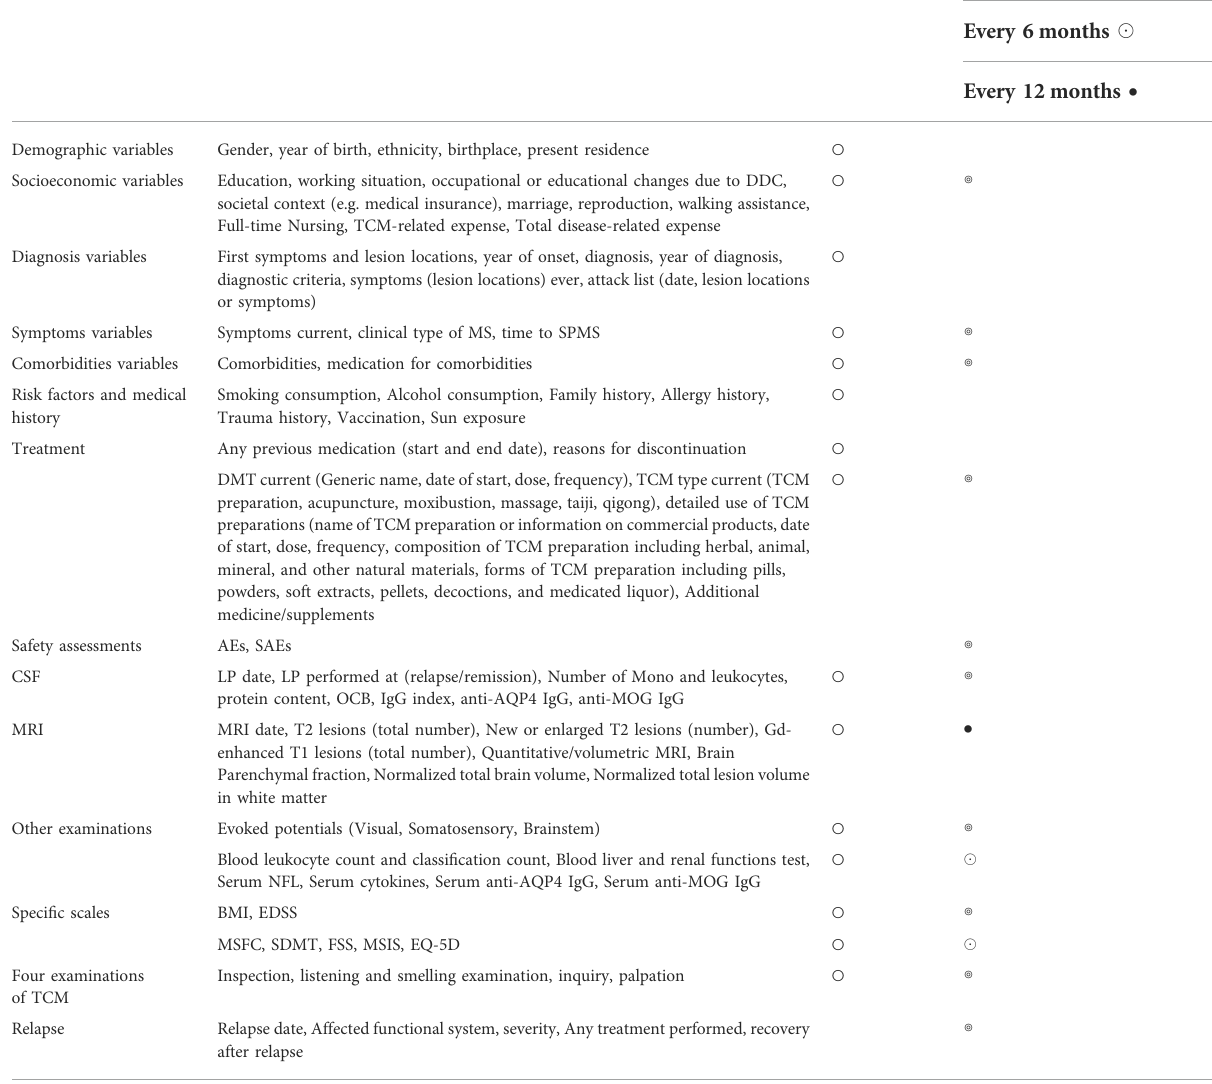
TABLE 1 Main variables and follow-up plan in the